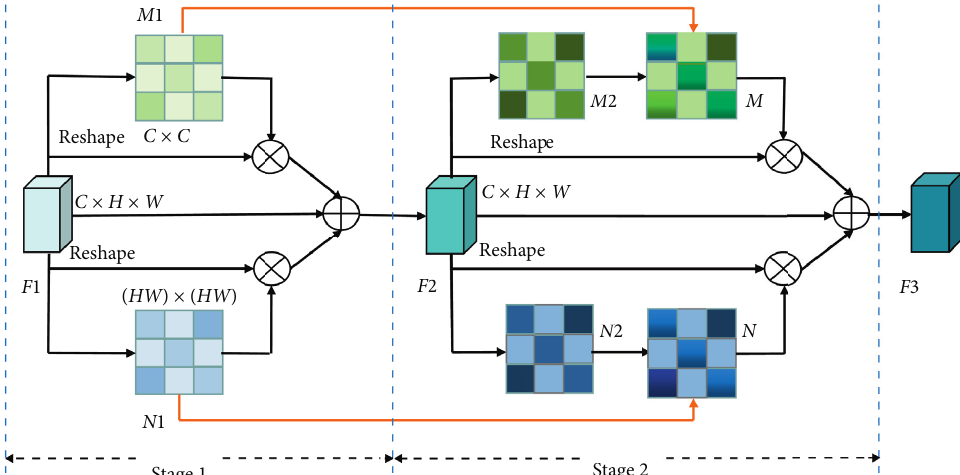
Figure 5: Structure diagram of Dual Ensemble Attention Module.